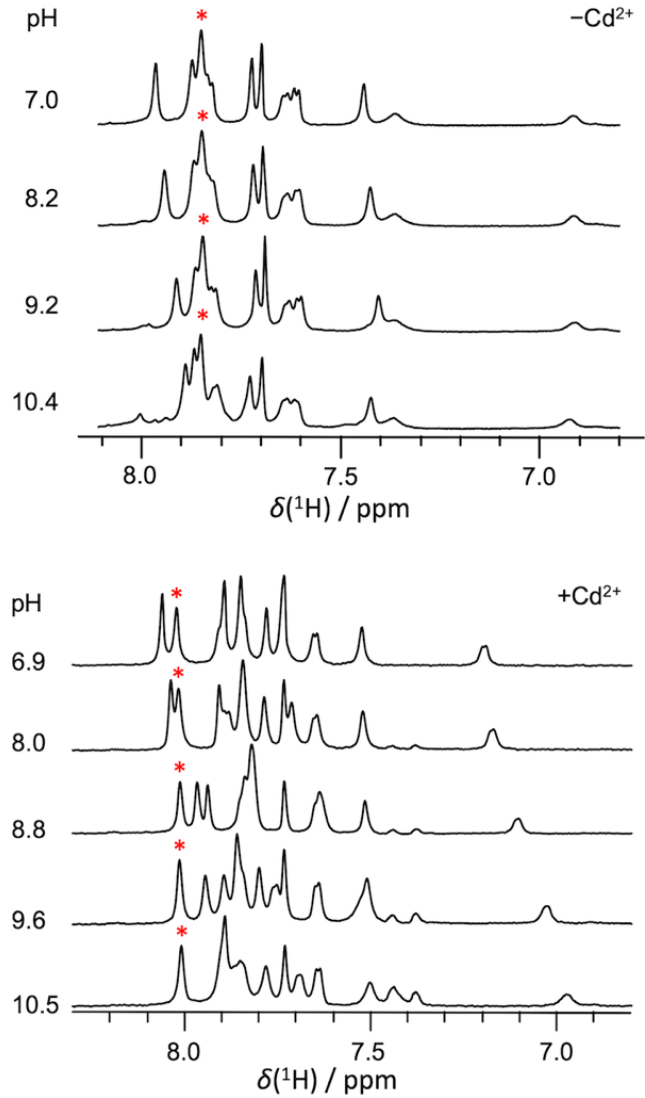
Figure 5. One-dimensional 1 H NMR spectra of the model RNA duplex 2 against various pH (basic region) in the absence/presence of CdCl 2 (two molar equivalents (2 mM) against the metal ion-binding A9-G10.1 motif). The H8(G12*) resonance is labeled with a red asterisk in each spectrum. Although chemical shift perturbations for several resonances were observed, these resonances were assigned to terminal residues. Above pH 9.22, a metal-dissociation process due to the Cd 2+ -precipitation under basic pH was observed. The 1D 1 H NMR spectrum of denatured duplex 2 at pH 10.9 in the absence of CdCl 2 is shown in Figure S4 in the Supplementary